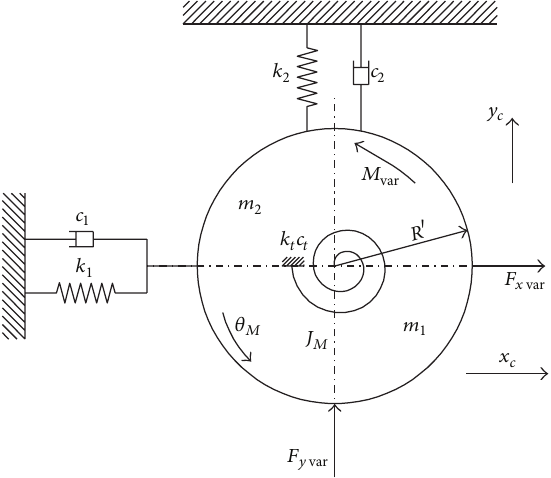
Figure 2: Simplified vertical-torsional-horizontal coupling struc- tural